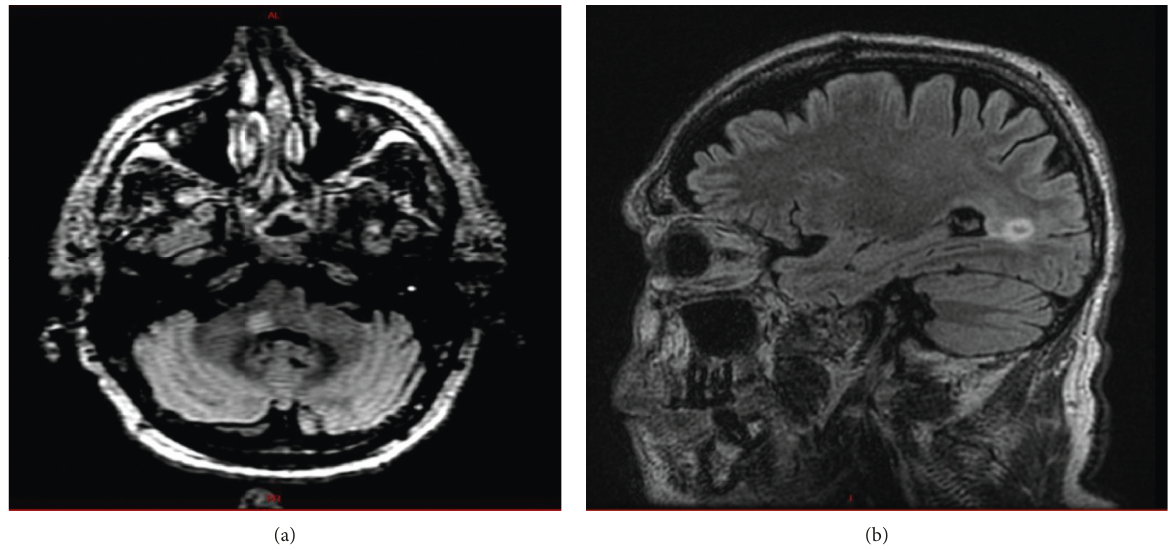
Figure 1: MRI of the brain showing hyperintense lesion in the right middle cerebellar peduncle lesion (a) and ring-shaped periatrial white matter lesion (b).